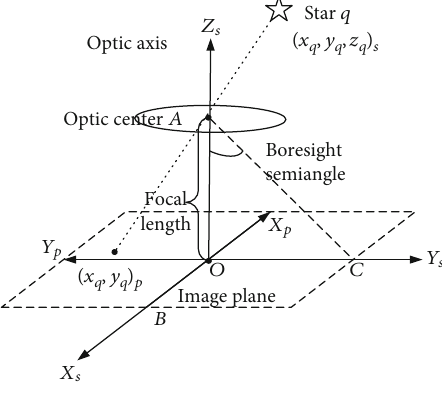
Figure 2: Imaging of a single-FoV star